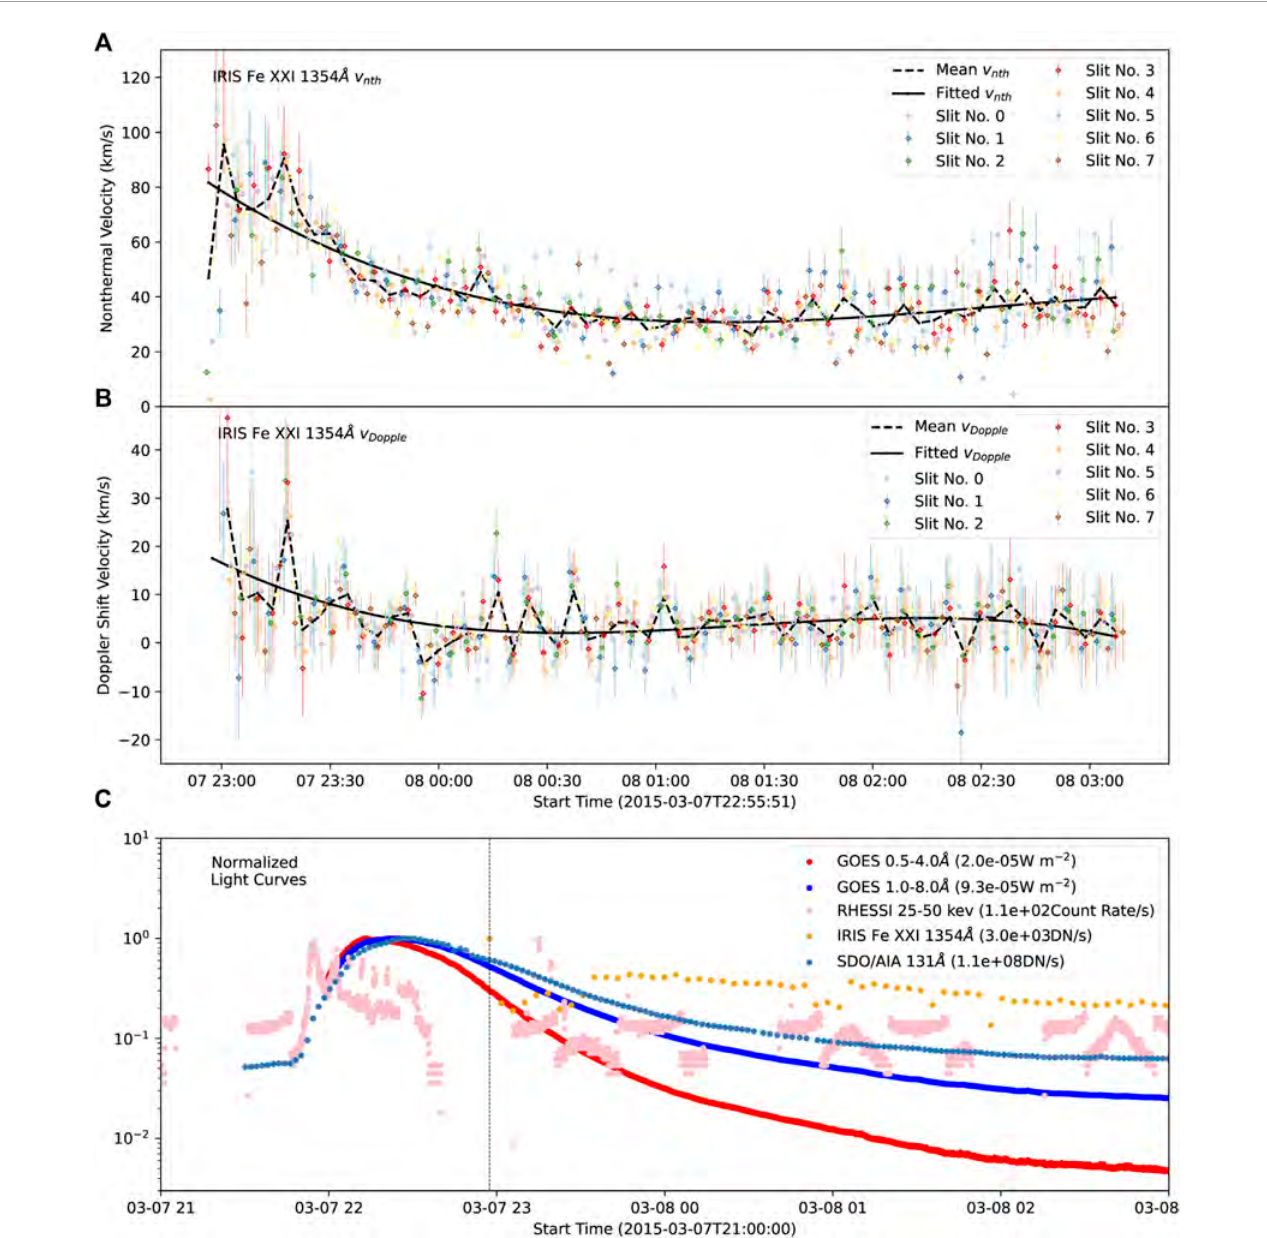
FIGURE 4 Panel (A) : non-thermal velocity of the Fe XXI 1354 Å line observed by the eight IRIS raster slits over time during the 2015–03–07 flare. The error bar indicates measurement errors based on the statistical error estimation. The dashed black line is for the mean values over eight slits, and the solid black line shows the third-order polynomial fitting profile based on the mean values. Panel (B) is for the Doppler shifting velocity of Fe XXI 1354 Å line in the same event. Panel (C) : normalized light curves of GOES and RHESSI, and the IRIS Fe XXI and SDO/AIA 131 flux in the chosen regions as shown in Figure 1 . The dashed vertical line indicates the starting time for the following analysis on IRIS Fe XXI 1354 Å